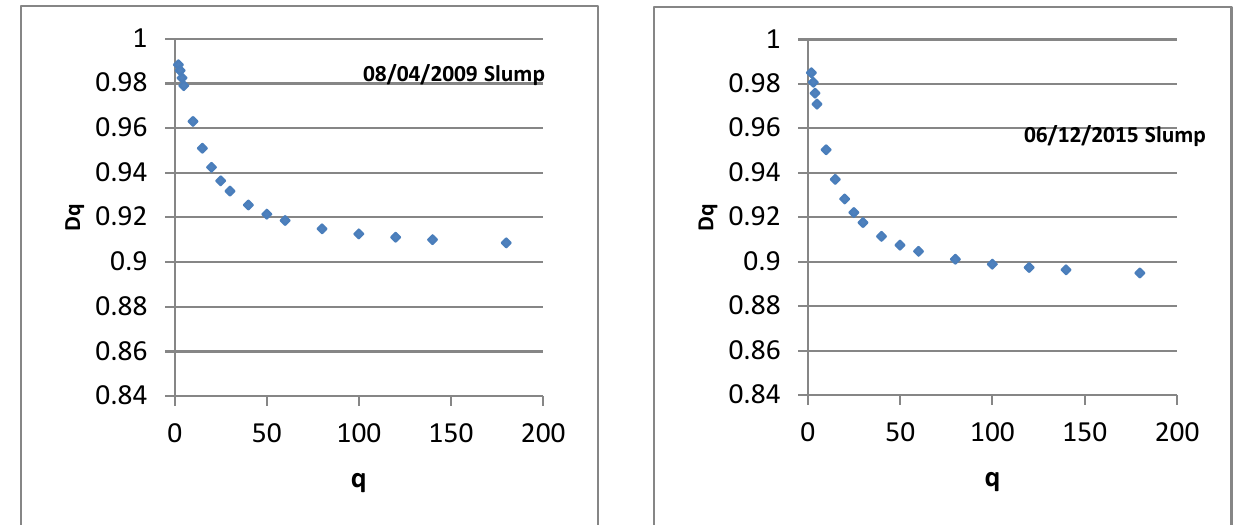
Figure 2. Generalized correlation dimensions Dq with different values of q.